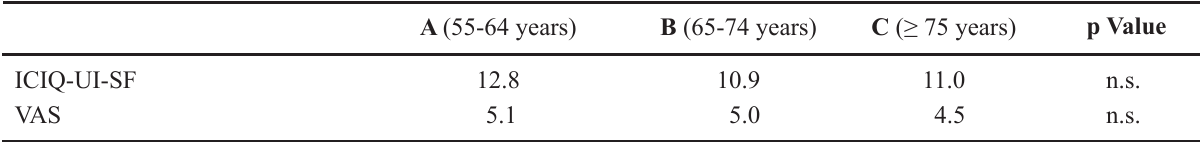
Table 2 – Quality of life in the studied population. ICIQ-UI-SF = International Consultation on Incontinence Question- naire on Urinary Incontinence Short Form; VAS = Visual Analog Scale.